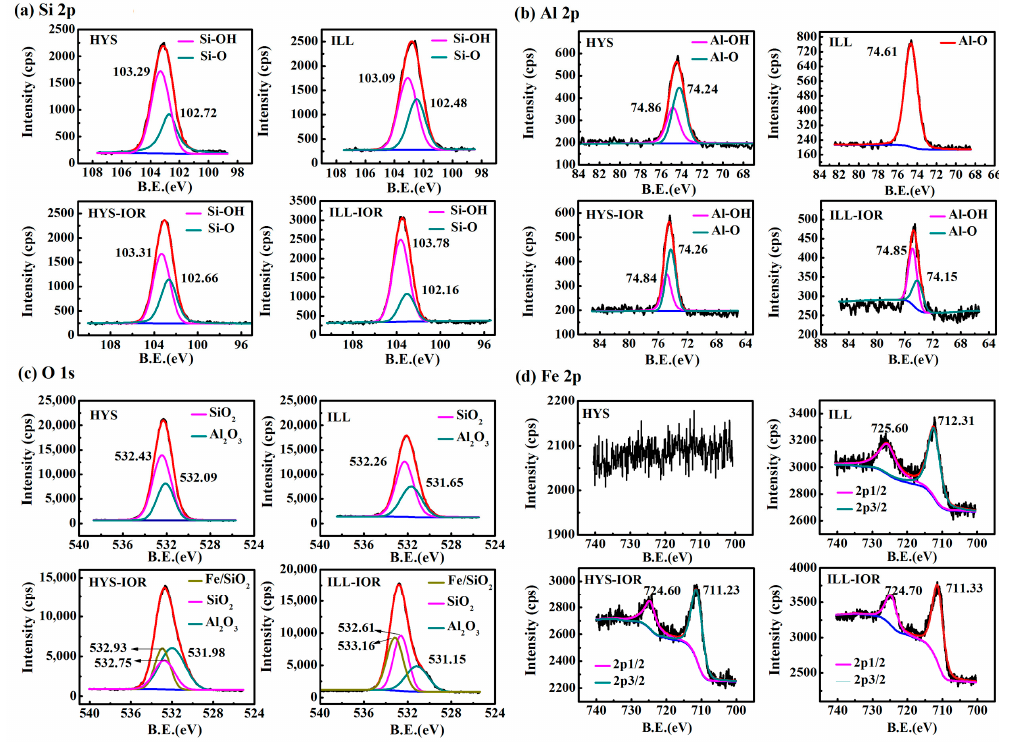
Figure 5. X-ray photoelectron spectroscopy (XPS) high-resolution scanning spectra of Halloysite (HYS), illite (ILL), HYS-IOR and ILL-IOR: ( a ) Si2p, ( b ) Al2p, ( c ) O1s, and ( d ) Fe2p.